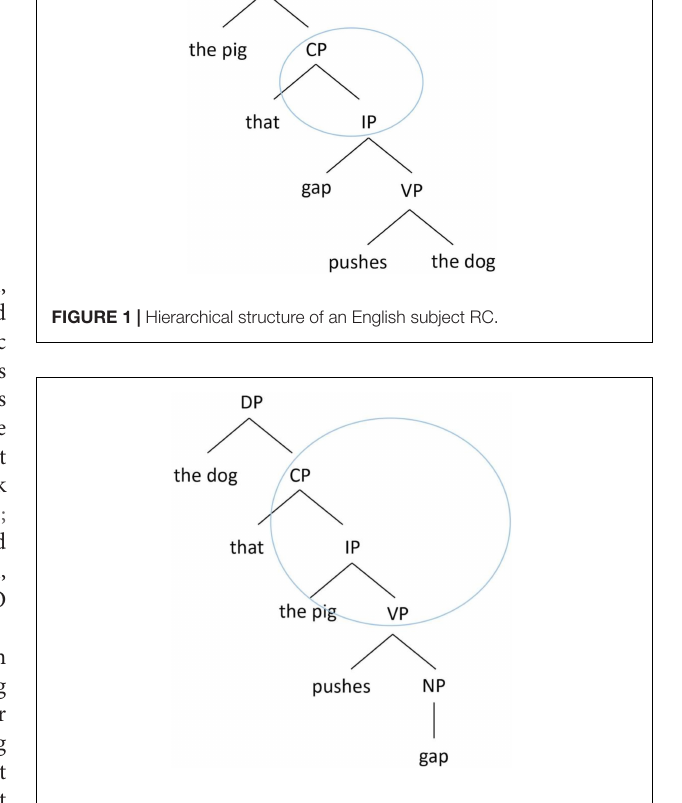
FIGURE 2 | Hierarchical structure of an English object